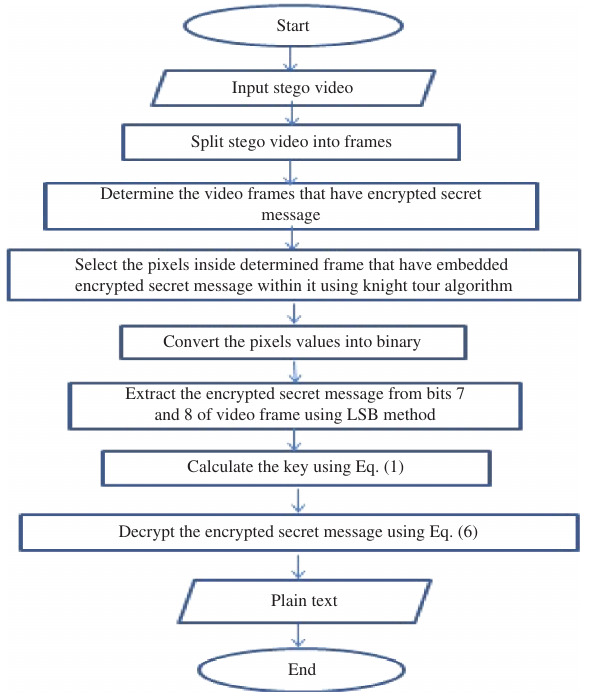
Figure 3: The Flow Chart of Extraction